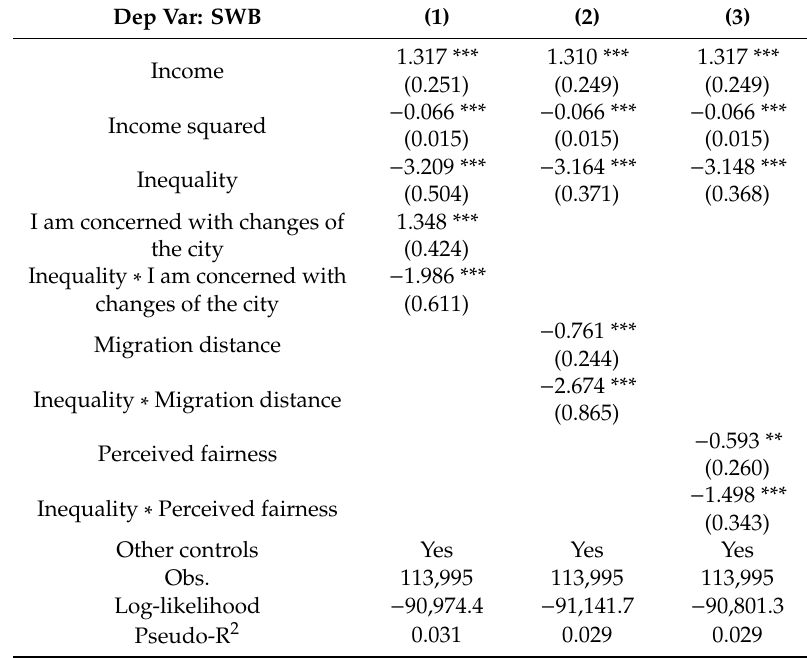
Table 9. Expectations and perceived fairness serve as the channels of